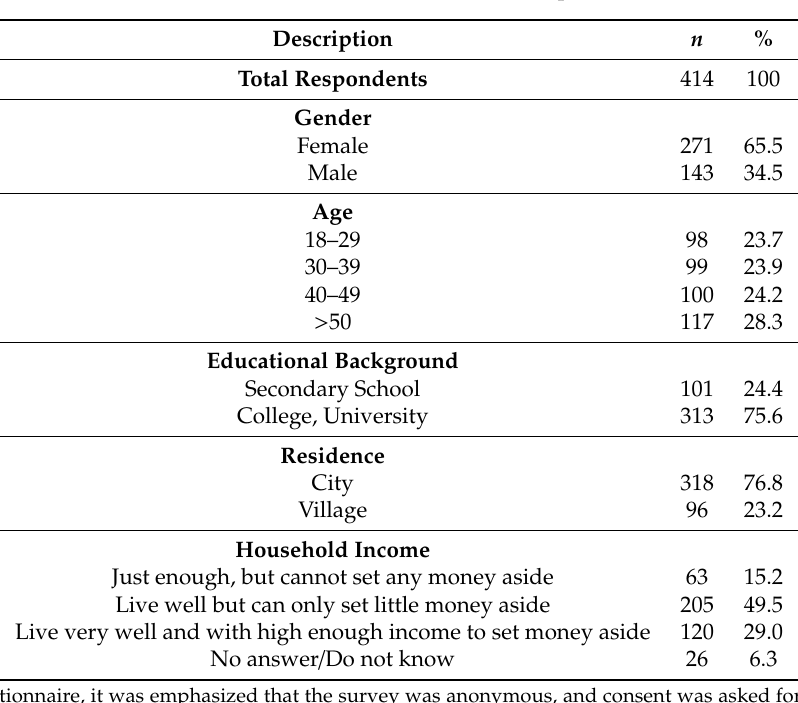
Table 1. The distribution of the